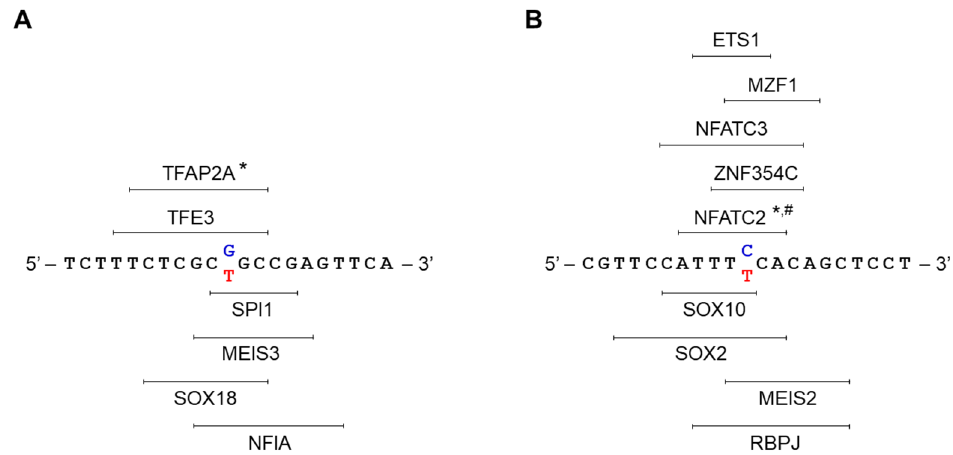
Figure 5. Transcription factor binding sites in the SCD5 promoter that were affected by rs6841081 ( A ) and rs3811792 ( B ) polymorphisms. The major alleles of the SNPs are marked in blue, and the minor polymorphic versions are in red in the DNA sequences. The exact binding sites of the transcription factors that were identified by the JASPAR online prediction program and filtered as described in Section 3 are plotted. TFs that are typed above the sequence are more likely to bind to the major allele, while TFs that are below the sequence prefer to bind to the minor polymorphic allele. Asterisk indicates results confirmed by PROMO, double cross shows hits confirmed by LASAGNA.